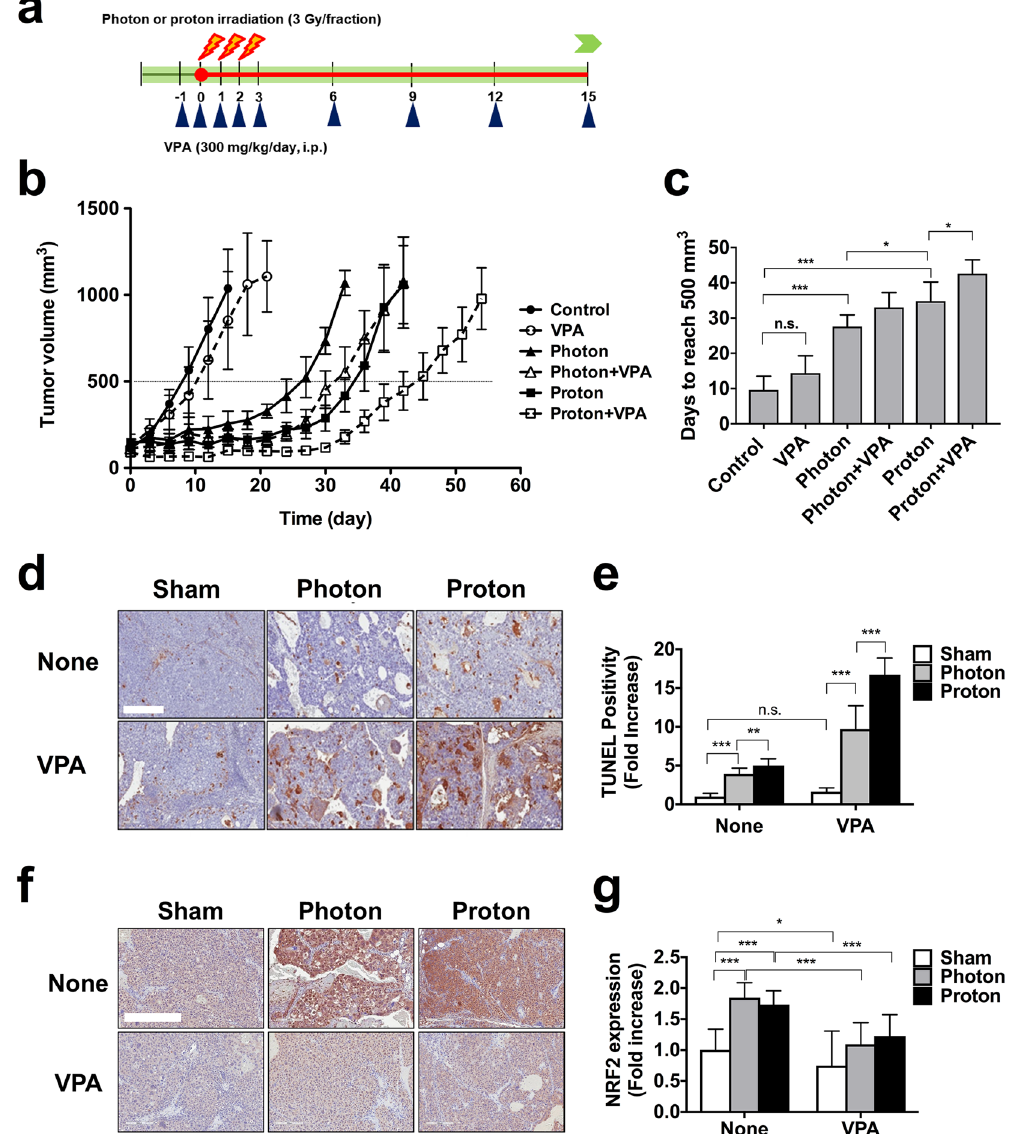
Figure 7. VPA enhances proton-induced tumor growth delay in a Hep3B xenograft model. ( a ) Schematic diagram of the experimental procedure. ( b ) Administration of VPA further suppressed growth of proton- irradiated tumors. Hep3B cells were implanted into right legs of BALB/c nude mice. Once tumors were palpable, they were irradiated with 3 Gy for 3 consecutive days for a total 9 Gy. Mice were treated with intraperitoneal injections of VPA (300 mg/kg/day) every 3 days. Shown are mean tumor volumes and standard deviation per group (n = 4). ( c ) Tumour growth delay was determined by calculating days each tumour taken to reach 500 mm 3 . n.s. not significant; * p < 0.05; *** p < 0.001. ( d ) TUNEL assay detected more apoptotic cells in tissues co- treated with proton and VPA compared to proton alone or combined photon and VPA. Little was seen in tissues treated with VPA alone. Scale bar, 400 µ m. ( e ) Quantification of the TUNEL positive cell density in tumor tissue sections. n.s. not significant; ** p < 0.01; *** p < 0.001. ( f ) Proton and photon irradiations increased NRF2 expression on tumour tissues, which was suppressed by co-treatment with VPA. NRF2 expression was assessed by immunohistochemistry. Scale bar, 400 µ m. ( g ) Quantification of NRF2 expression in tissue samples. * p < 0.05; *** p <